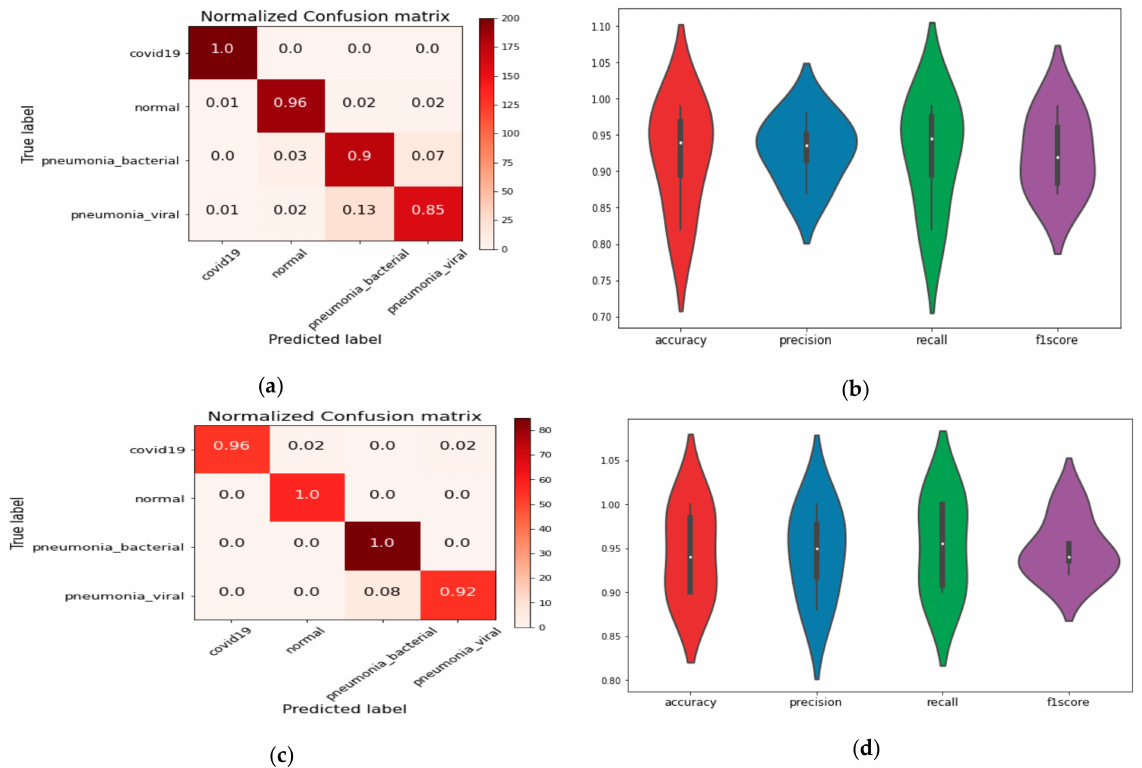
Figure 6. ( a ) The confusion matrix for Xception model. ( b ) Performance analysis based on Xception DL model. ( c ) Confusion matrix for CoVIRNet DL model. ( d ) Performance analysis based on CoVIRNet DL